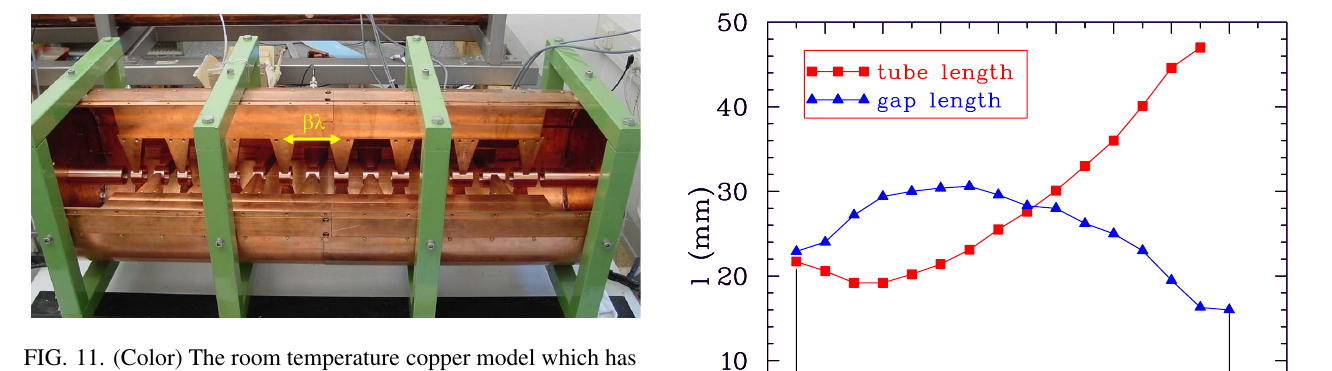
FIG. 11. (Color) The room temperature copper model which has been used to validate the electromagnetic simulations. This photograph shows the model with a graded beta from 0.085 to 0.12.